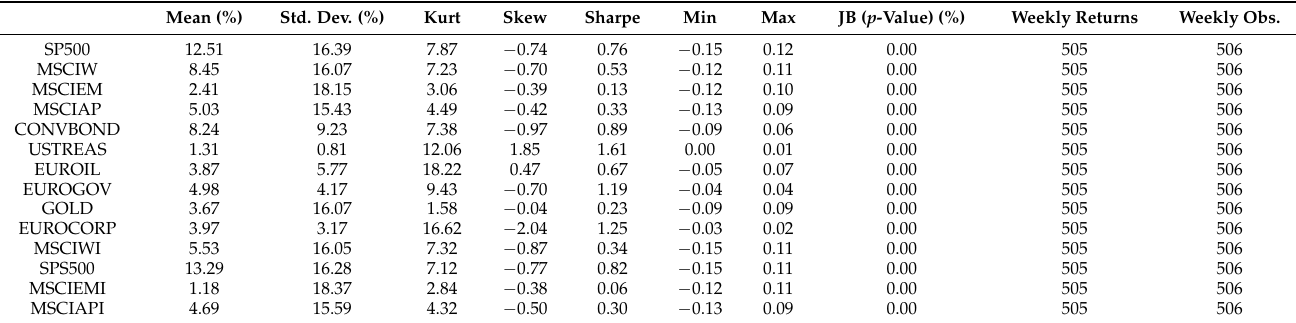
Table 3. Descriptive statistics of asset